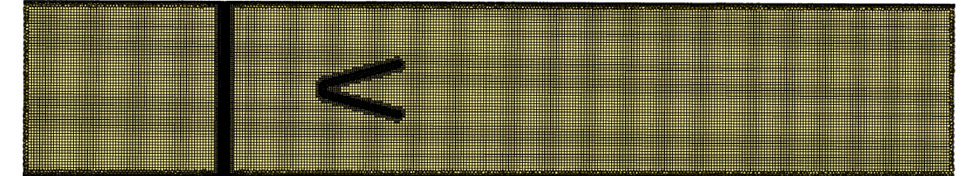
Figure 2. Schematic diagram of the calculation domain model.